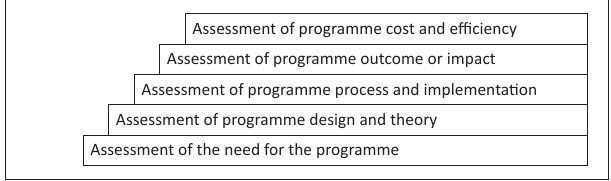
FIGURE 2: Step-wise model of programme